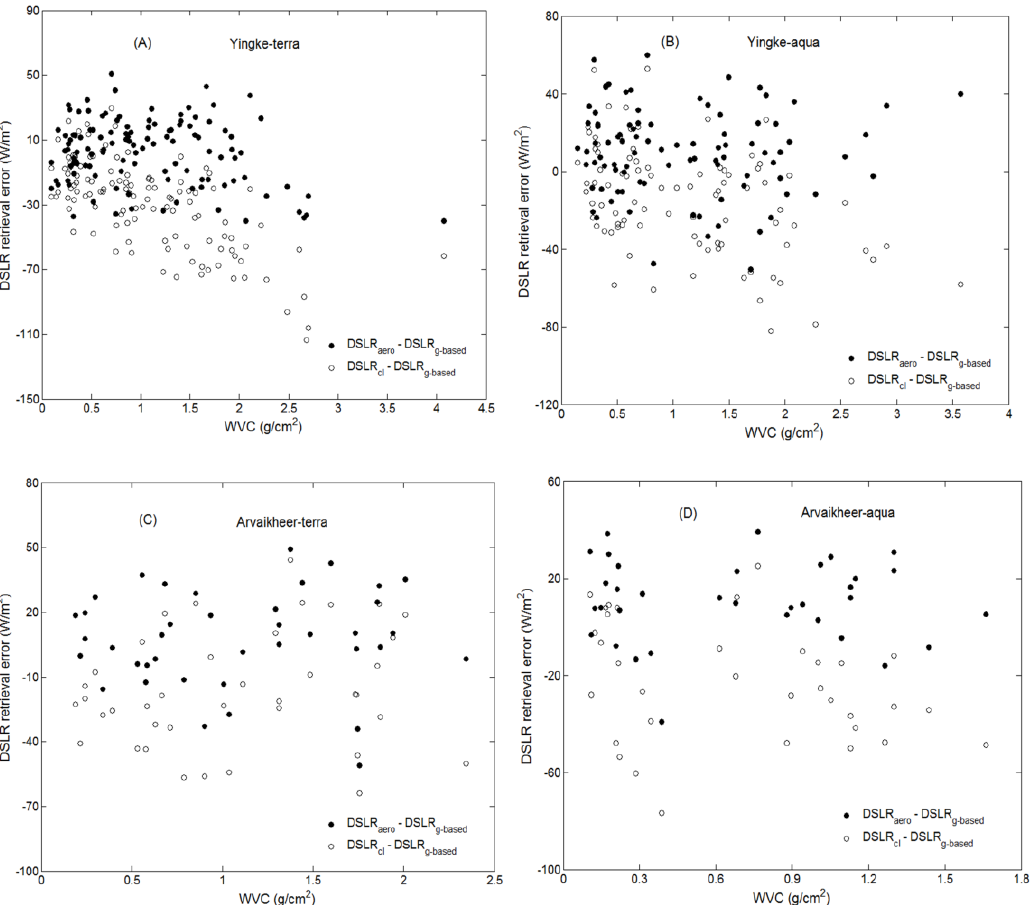
Figure 13. The retrieval errors between DSLR extracted from MODIS data with the proposed (solid circles) and DSLR cl methods (hollow circles) and those groundbased measurements versus WVC at two test sites for dust aerosol conditions at the moment of MODIS overpass. ( A ) Yingke-terra; ( B ) Yingke-aqua; ( C ) Arvaikheer-terra; ( D ) Arvaikheer-aqua.